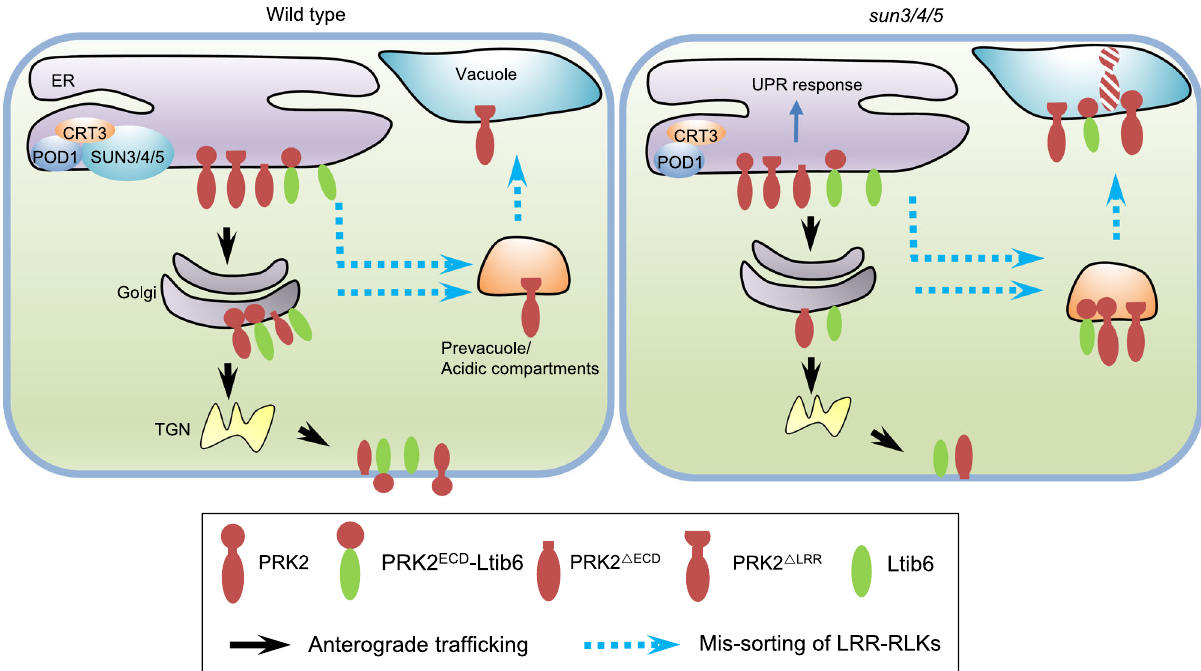
Fig. 7 A working model of SUN3/4/5 in guarding the ER sorting of LRR-RKs. SUN3/4/5-POD1-CRT3 on the ER membrane guards the quality control of LRR-RKs to ensure proper sorting of LRR-RKs and chimeric PRK2 ECD -Ltib6 to the plasma membrane. Deletion of the LRR domain (PRK2 Δ LRR ) directs the truncated protein to the acidic compartments for degradation in the WT and sun3/4/5 . In sun3/4/5 , the full-length LRR-RKs and chimeric protein PRK2 ECD - Ltib6 are missorted to the acidic compartments, like the effect of deletion of the LRR domain (PRK2 Δ LRR ). For LRR-RKs with all the extracellular domain deleted (PRK2 Δ ECD ), they could be sorted to the plasma